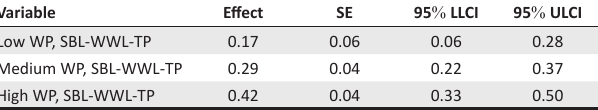
FIGURE 1: Interaction plot of strengths-based leadership and work pressure on work-related well-being. TABLE 4: Conditional indirect effects of strengths-based leadership on task performance via work-related well-being, at levels of work pressure. Variable